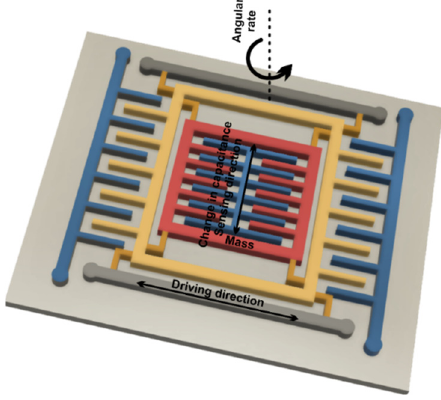
Figure 5. Microstructure of a gyroscope.